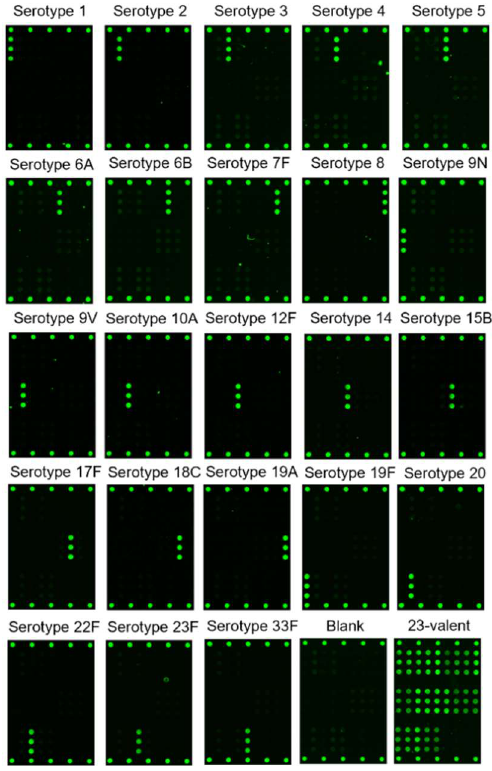
Figure 2. Representative fluorescence microarray images demonstrating reactivity and specificity of the VaxArray pneumococcal assay after the incubation of 2 µg/mL monovalent Pfizer native PS serotypes 1, 2, 3, 4, 5, 6A, 6B, 7F, 8, 9N, 9V, 10A, 12F, 14, 15B, 17F, 18C, 19A, 19F, 20, 22F, 23F, and 33F (ATCC, deposited by Pfizer); a no antigen blank; and a 23-valent mixture containing all sero- types mentioned above.